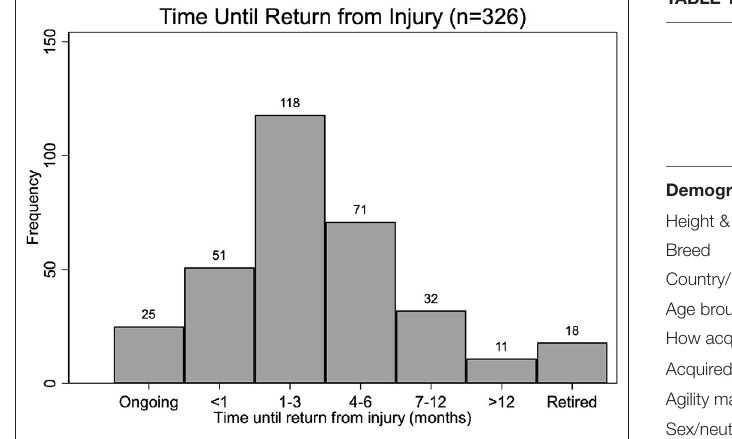
TABLE 1 | All factors considered in model